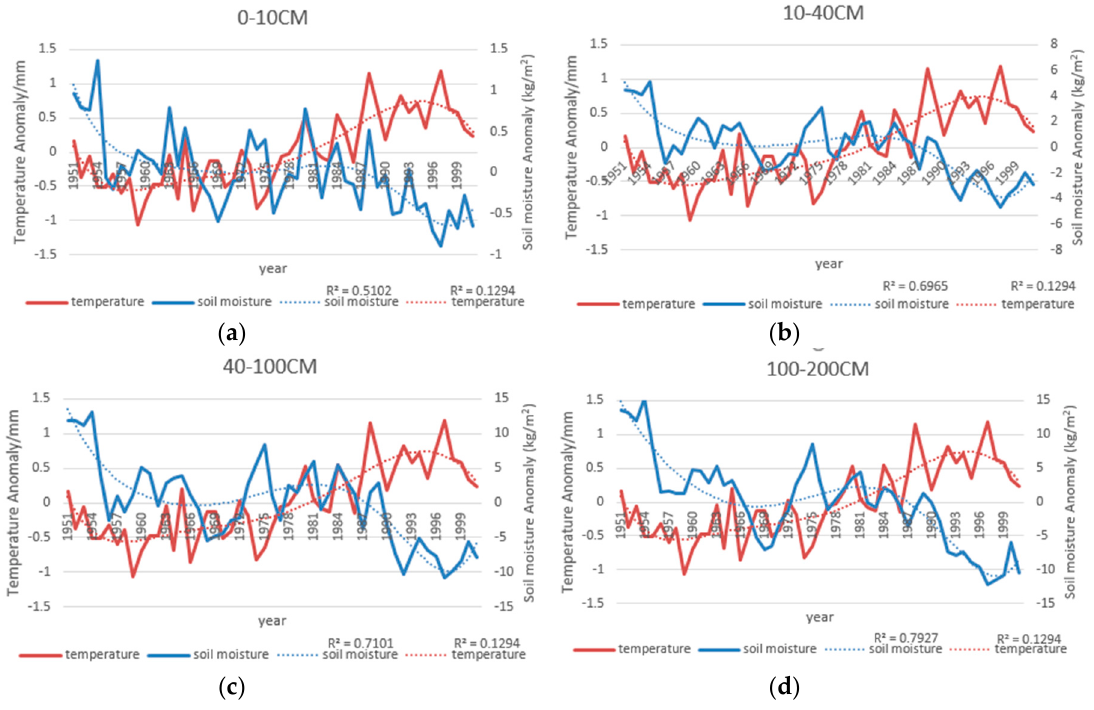
Figure 10. The relationship of annual average temperature anomaly (red line) and the layers of soil moisture (blue line) from 1961 to 2011 in eastern China: ( a ) 0–10 cm; ( b ) 10–40 cm; ( c ) 40–100 cm; ( d ) 100–200 cm.